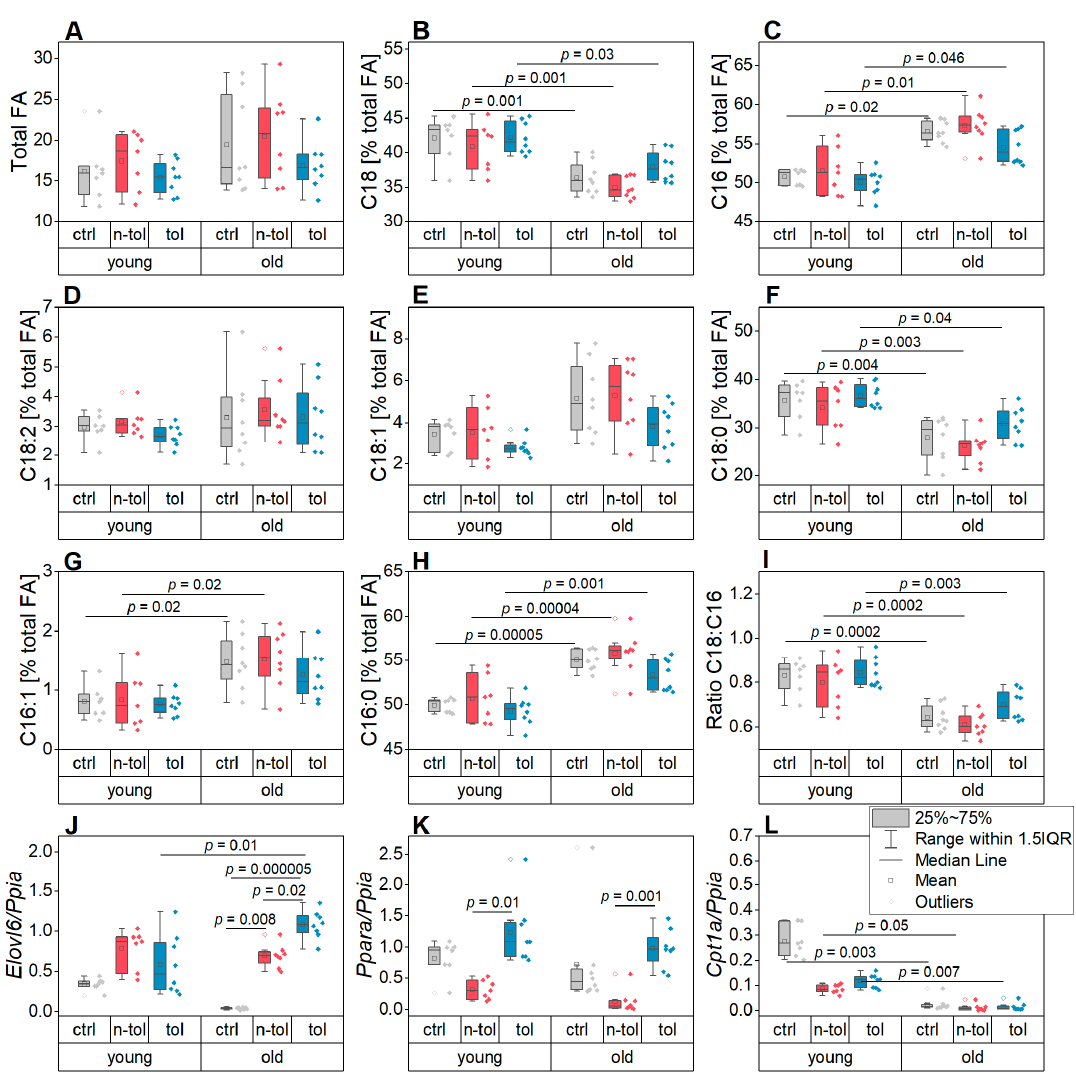
Figure 2. Fatty acids (FAs) and relative gene expression of relevant markers in liver tissue. Data are shown for young and old mice as well as control (ctrl), non-tolerant (n-tol), and tolerant (tol) mice in each age group. ( A ) Total amount of FAs. ( B , C ) Sum of all ( B ) C18 and ( C ) C16 FAs shown as percentage of the total amount of FAs, respectively. ( D – H ) The C18 and C16 FAs with the highest relative concentrations per mg dry tissue weight shown as percentage of total FA amount: ( D ) linoleic acid (C18:2), ( E ) oleic acid (C18:1), ( F ) stearic acid (C18:0), ( G ) palmitoleic acid (C16:1), and ( H ) palmitic acid (C16:0). ( I ) Ratio of C18/C16 FAs. ( J – L ) Relative expression of genes involved in lipid synthesis and lysis: ( J ) Elovl6 , ( K ) Ppara , ( L ) and Cpt1a .